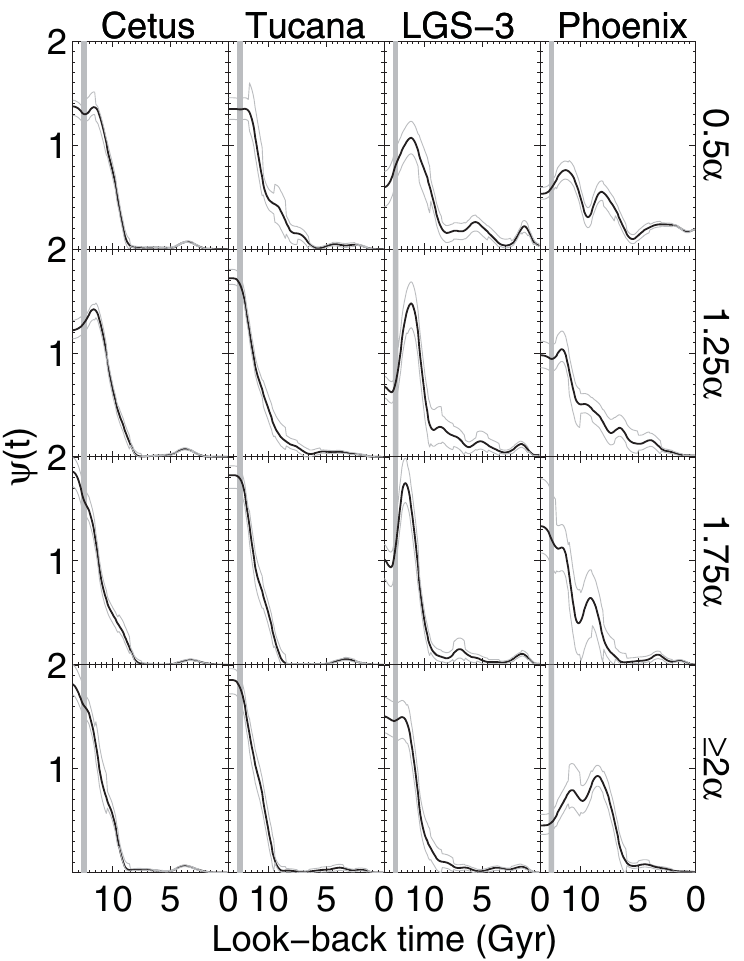
Figure 2. SFHs as a function of radius obtained from the CMDs shown in 1. The gray shaded region points to the epoch of reionization.